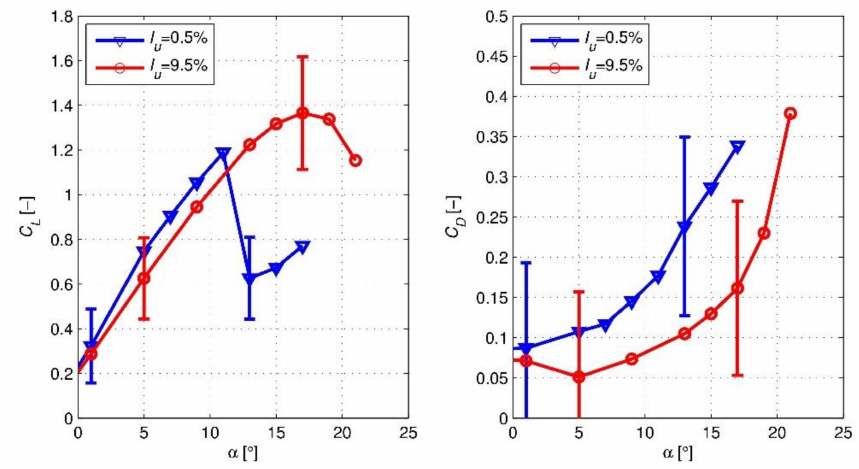
Figure 7. Experimental polars for the virtually cambered airfoil at Re = 80